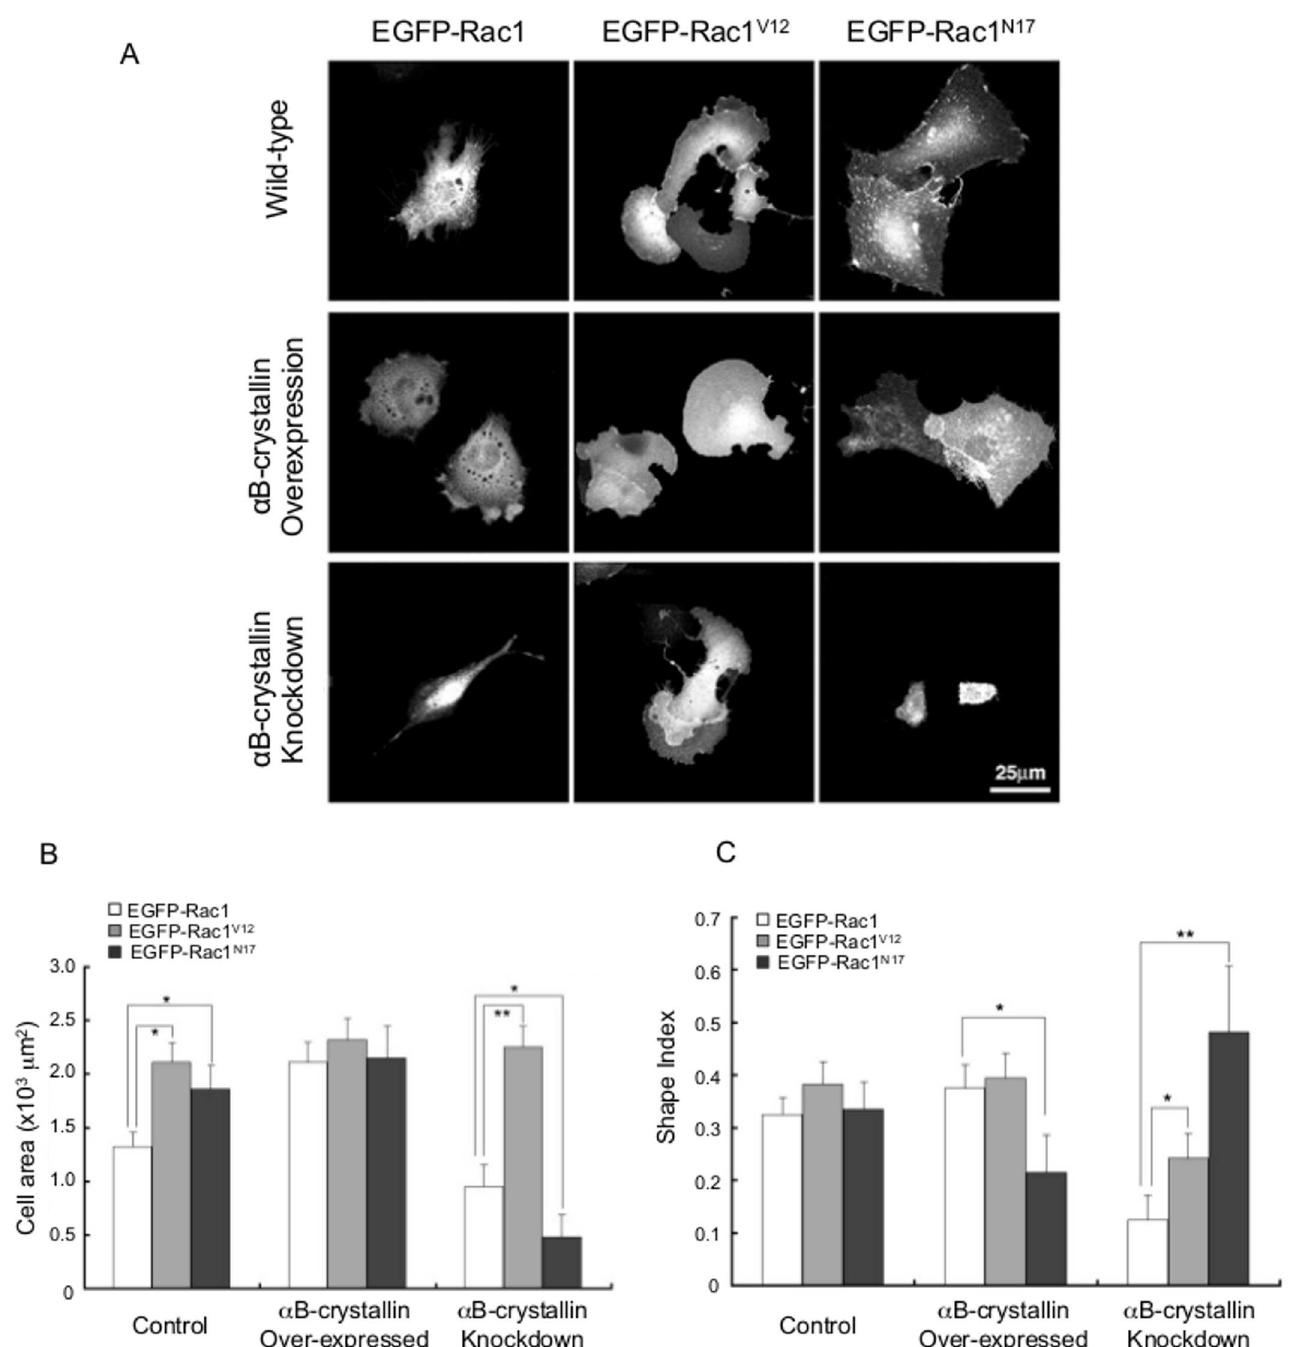
Fig 7. Impact of Rac1 on morphology of α B-crystallin-overexpressing and knockdown cells. C6 cells were transfected with EGFP-Rac1 (wild-type), EGFP-constitutively active Rac1 (V12), and EGFP-dominant-negative Rac1 (N17), and fluorescence images were taken after 12 h. α B- crystallin knockdown C6 cells that expressedRac 1 V12 showedenlargedperipheralruffles at both ends of spindle-shaped cells. On the other hand, completeloss of lengthenedpseudopodswas observed in Rac1 N17 transfected cells (A). Area change (B) and shapeindex (C) of EGFP-Rac1, Rac1 V12 , Rac1 N17 expressedwild-type, α B-crystallin overexpressed, and knockdown C6 cells. ** = P < 0.01, * P = 0.05, n = 50.